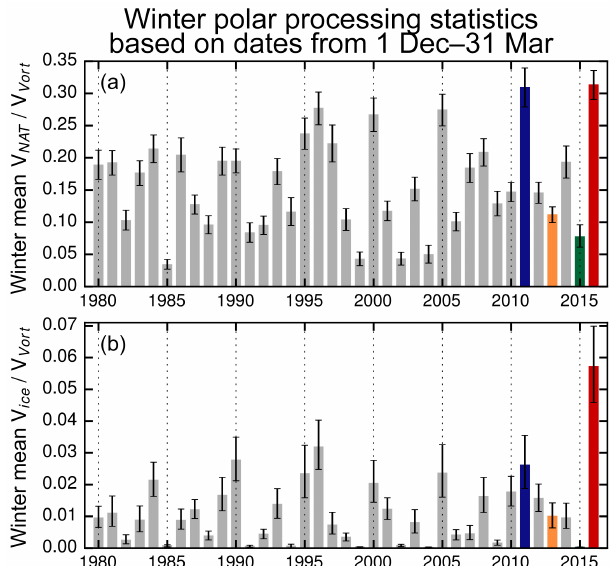
Figure 3. Winter polar processing statistics based on temperatures from the MERRA-2 reanalysis: (a) winter mean V NAT /V Vort , and (b) winter mean V ice /V Vort . All bars are calculated from time series data limited to 1 December through 31 March, using isentropic lev- els between 390 and 580K (nominally between ∼ 380 and 565K, using midpoint levels to estimate altitudes). Error bars represent the sensitivity of these diagnostics to using ± 0.5K offsets to the PSC formation thresholds at each level. Year numbers are for the January of each winter; 2011, 2013, 2015, and 2016 are highlighted as the blue, orange, green, and red bars,